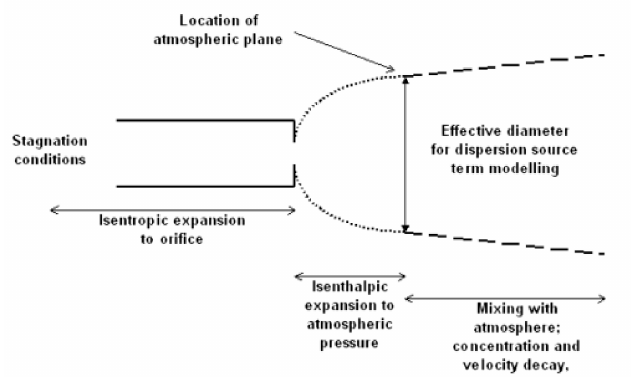
Figure 2. Schematic diagram of the expansion zone (Reproduced from Pursell